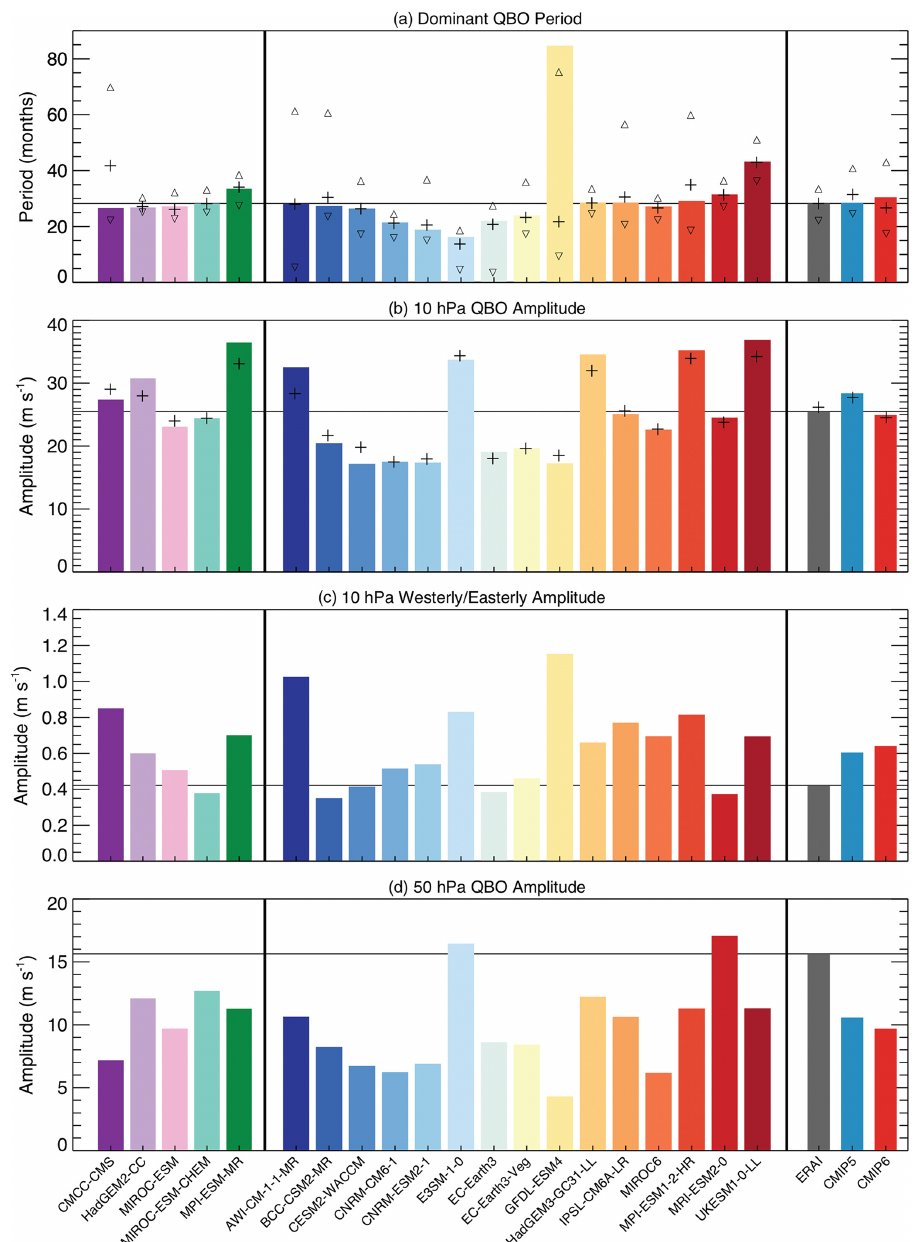
Figure 14. (a) QBO periods, (b) 10hPa QBO amplitude, (c) 10hPa ratio of westerly (eastward) to easterly (westward) QBO amplitude, and (d) 50hPa QBO amplitude for models that participated in phases 5 (leftmost five bars) and 6 (middle 15bars) of the Coupled Model Intercomparison Project (CMIP; Eyring et al., 2016; Taylor et al., 2012). CMIP5 and CMIP6 ensemble means are compared on the right with the corresponding ERA-Interim (Dee et al., 2011) results. The triangles in panel (a) indicate the range of periods. Periods and amplitude obtained using different diagnostics are shown by the + symbol in panels (a) and (b) to confirm robustness of the conclusions. Figure 2 from Richter et al. (2020). ©American Geophysical